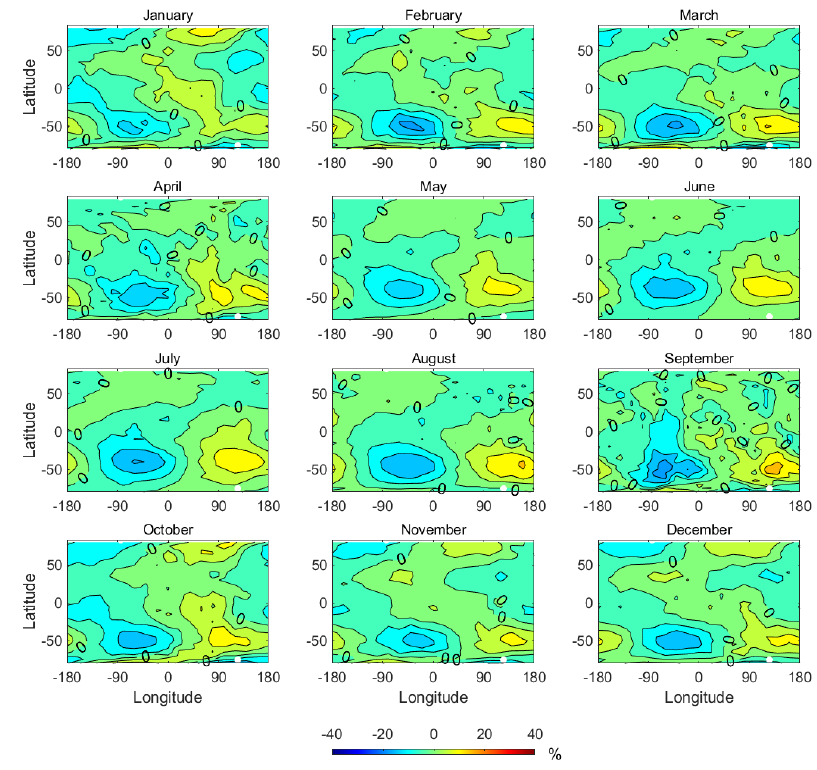
Figure 9. Same as Figure 7, except for the atmospheric average molecular weight.